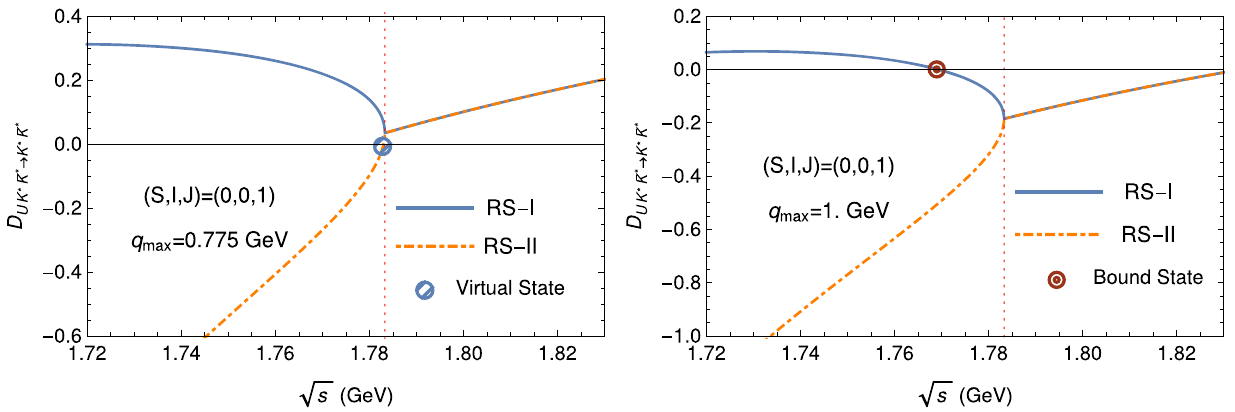
Fig. 5 The D U functions for the K ∗ ¯ K ∗ → K ∗ ¯ K ∗ with ( S , I , J ) = ( 0 , 0 , 1 ) on the real axis on the physical Riemann sheet with the cutoff q max = 0 . 775 GeV and 1.0 GeV, respectively. The artificial pole is denoted as red cross and the pole associated with a bound state is denoted as a circle